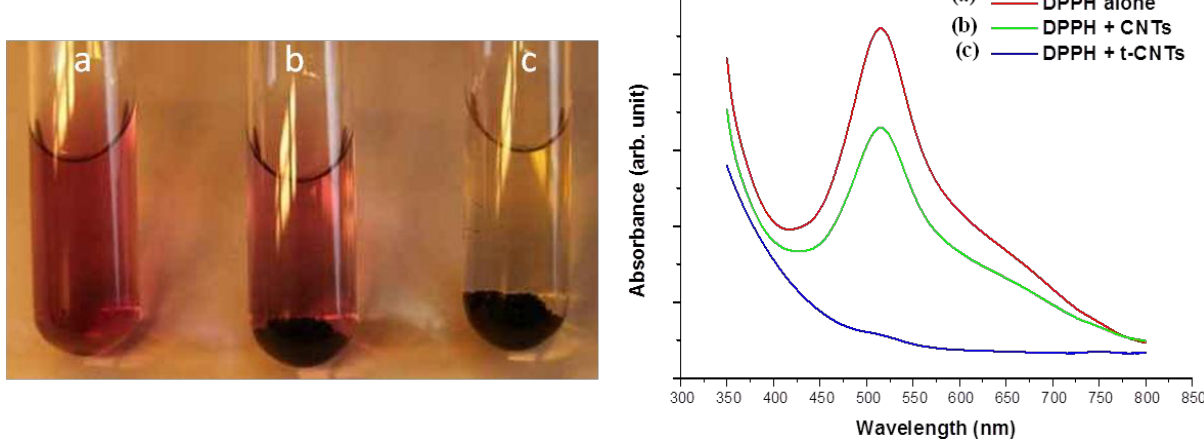
Figure 2. Qualitative assessment of the presence of radicals on the surface of freshly treated CNTs. Photograph and absorption spectrophotometric analysis of ( a ) 2,2-diphenyl-1- picrylhydrazyl (DPPH) solution alone, ( b ) DPPH solution in presence of pristine CNTs and ( c ) DPPH solution in presence of freshly treated CNTs